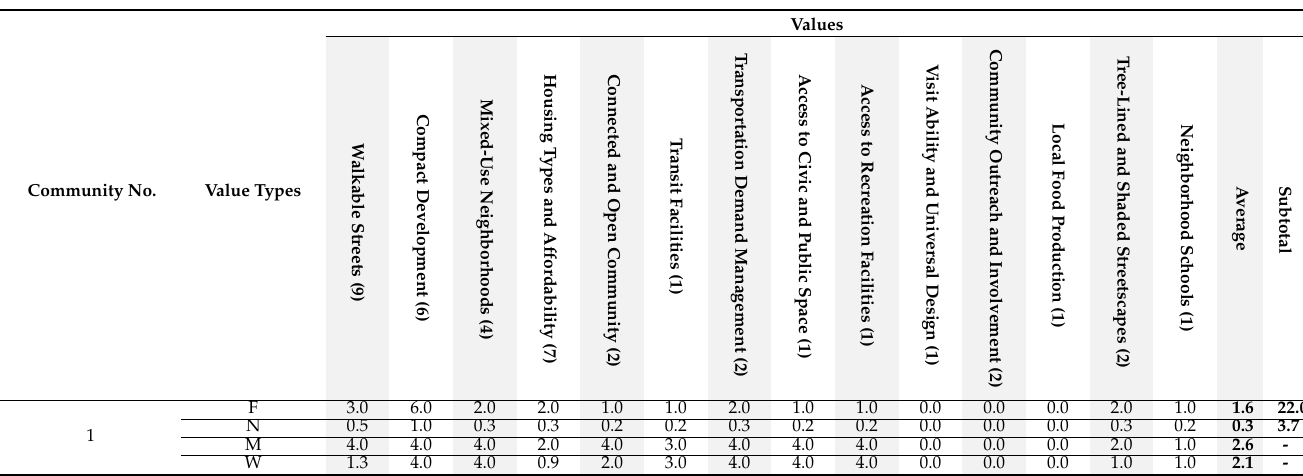
Table 3. Scoring results of neighborhood pattern &